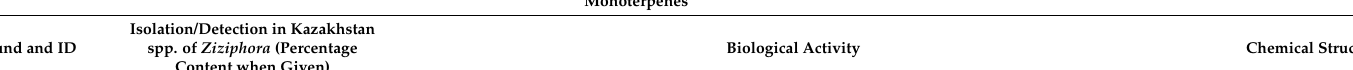
Table 3. Cont. Monoterpenes